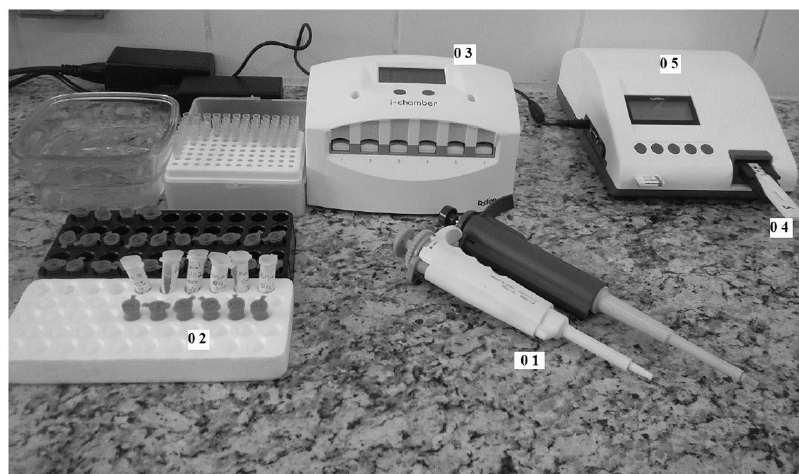
Figure 2. Cortisol analysis using the Ichroma Cortisol TM device, showing 30 µ L and 75 µ L pipettes (01), detection buffer tubes - orange color (02), incubator (03), sample loaded cassette (04), and scanner